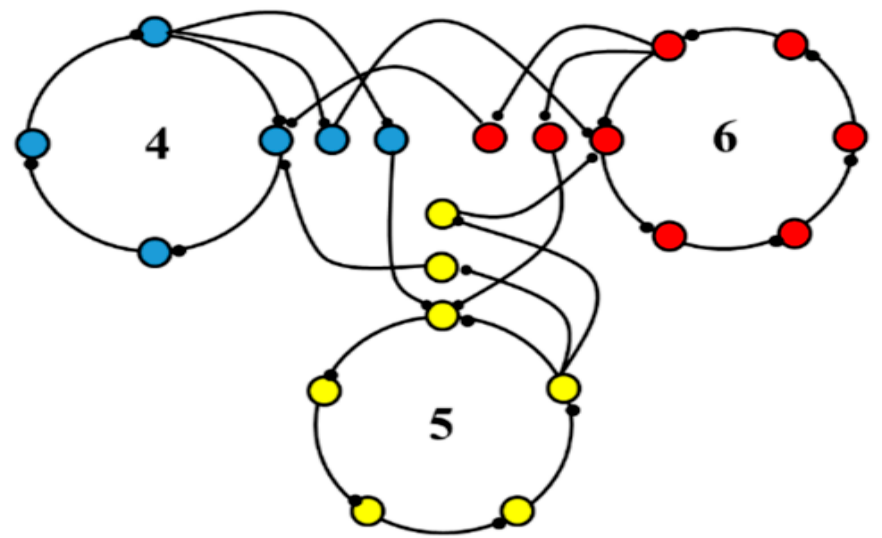
Figure 23. One instantiation of the four-oscillator network. There are three oscillators that consist of four, five, and six nodes, respectively. Each node contains 100 neurons. In each oscillator, a designative node is also connected to the corresponding node in the other oscillators, creating a loosely coupled network. The neurons in each node received inputs from all neurons in the previous node and sent outputs to each neuron in the subsequent node [1].